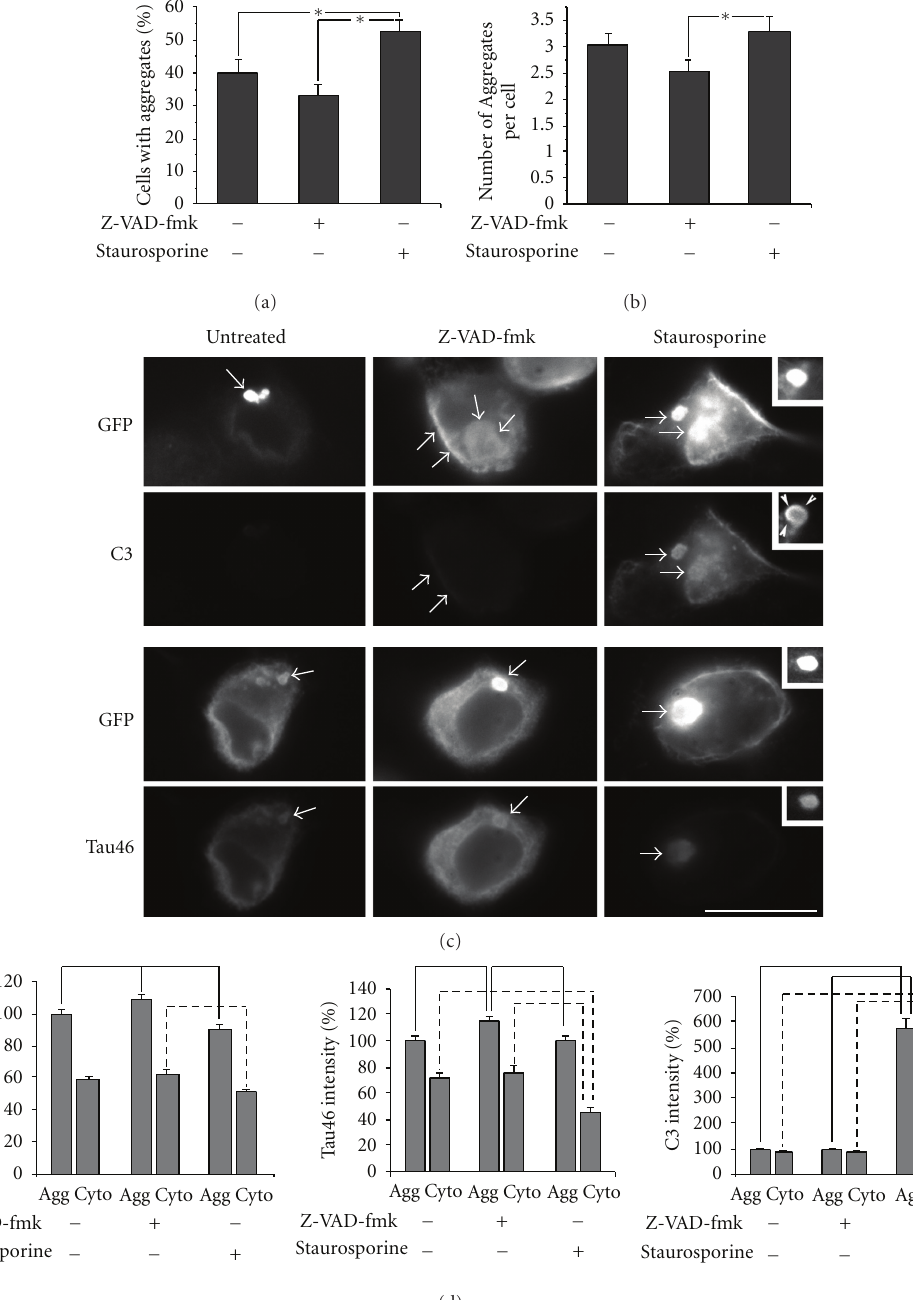
Figure 3: E ff ect of Z-VAD-fmk and staurosporine on aggregation and truncation. (a) presents quantification of the percentage of cells containing aggregates as detected by GFP with and without pharmacological manipulation of caspase activity. (b) presents quantification of the number of aggregates per cell. Note that staurosporine significantly increased, while Z-VAD-fmk induced a detectable but nonstatistically significant decrease, the percentage of cells with aggregates as well as the number of aggregates per cell. Values represent the mean ± SEM from 3 independent experiments ( ∗ P < 0 . 05, Student’s t -test). (c) presents double immunofluorescent staining with anti-GFP and either C3 (upper images) or Tau46 (lower images) with and without treatment with Z-VAD-fmk or staurosporine as indicated. The bar represents 20 μ m. Arrows indicate representative aggregates. Note that staurosporine-treated cells display stronger C3 immunoreactivity within aggregates and very weak Tau46 immunoreactivity within the cytosol. Staurosporine panels include insets from a di ff erent transfected cell to highlight that C3, but not Tau46 or GFP, is localized around the periphery of some aggregates. (d) presents quantification of immunofluorescence intensity of anti-GFP, C3 and Tau46 between aggregates and adjacent cytosolic tau in the same cells. All bars connected by lines are statistically di ff erent ( P < 0 . 05; Student’s t -test); continuous lines connect values for aggregates, while dotted lines connect values for cytosol. Values represent the mean ± SEM ( P < 0 . 05, Student’s t